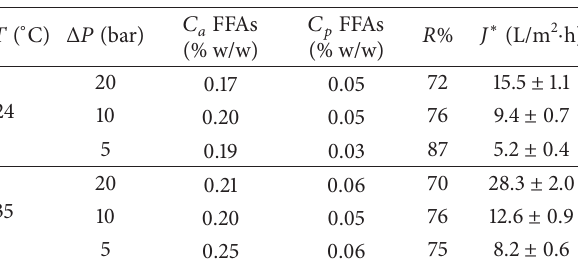
Table 2: Flux and FFAs retention ( 𝑅 %) during recovery ethanol using the NF